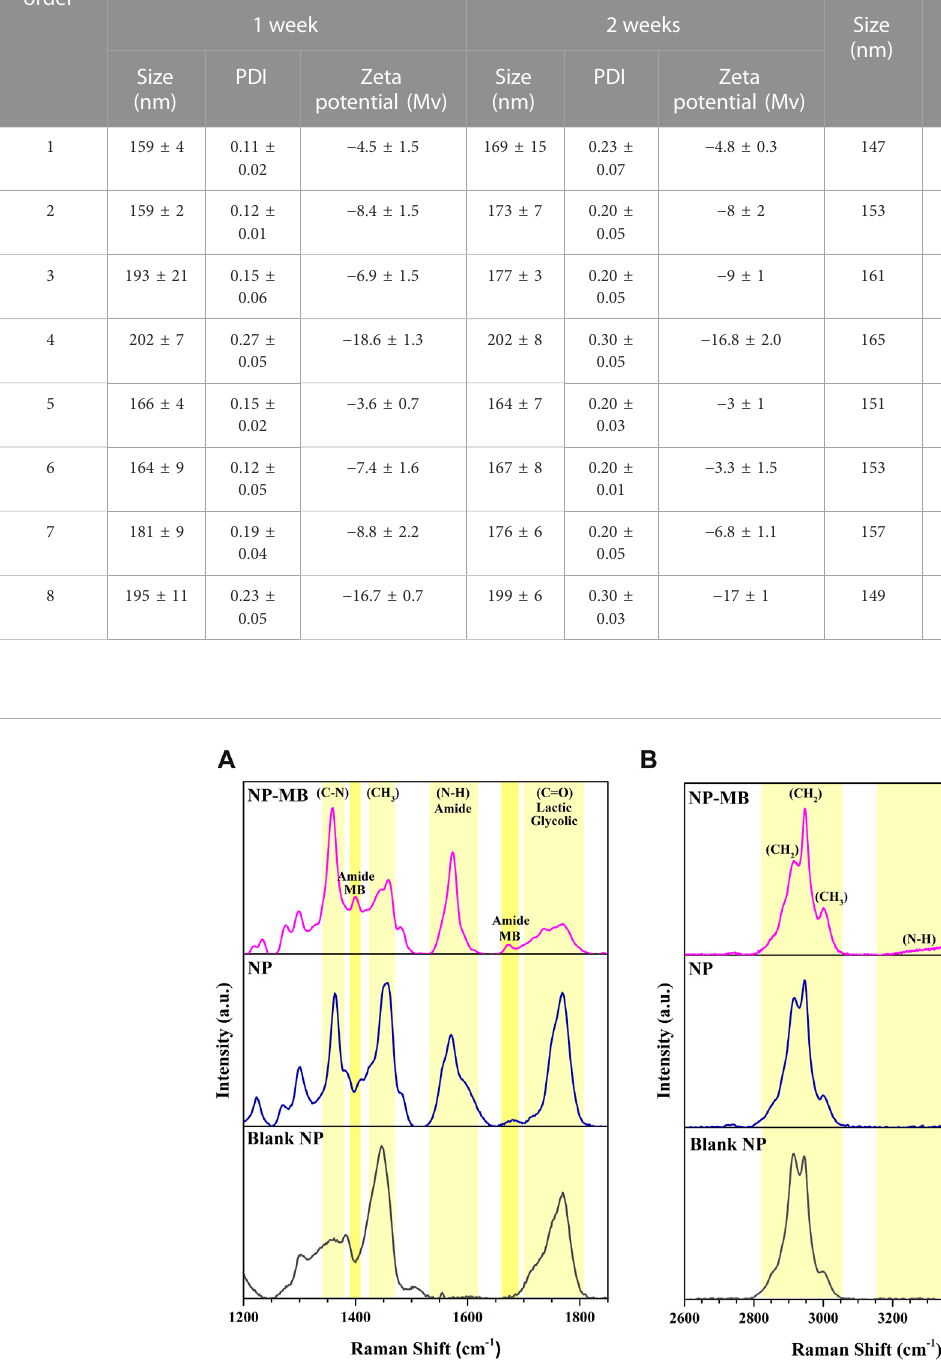
FIGURE 5 Raman spectra of Blank NP, NP and optimized NP-MB. (A) Raman shift from 1200 to 1900 cm -1 . (B) Raman shift from 2600 to 3600 cm -1